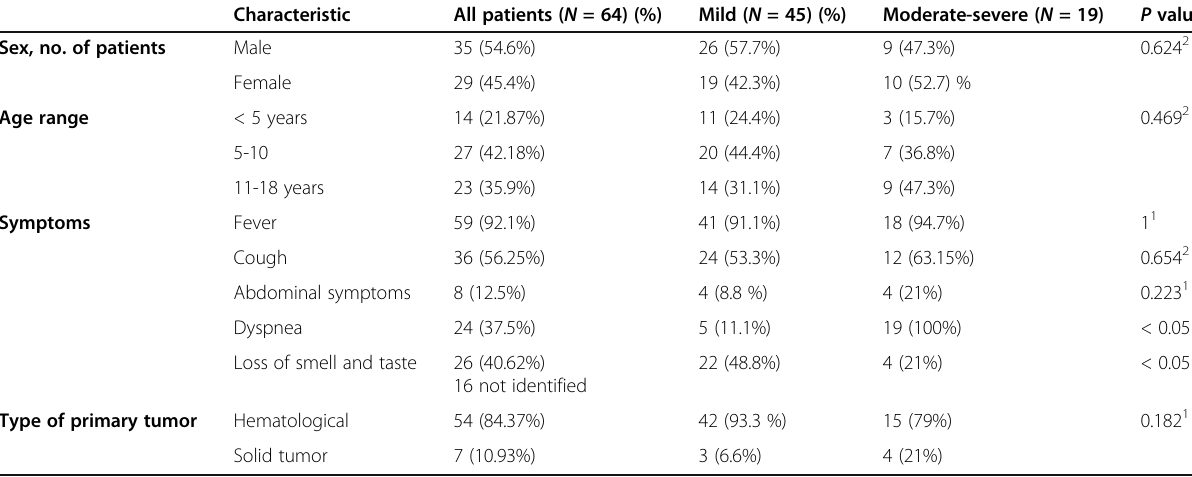
Table 1 Summary of patient characteristics Characteristic All patients ( N = 64) (%) Mild ( N = 45) (%) Moderate-severe ( N = 19) P value Sex, no. of patients Male 35